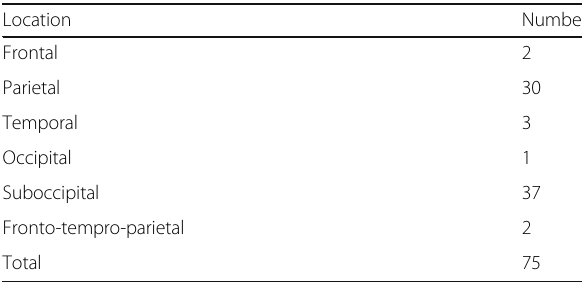
Table 2 Location of reconstruction cranioplasty